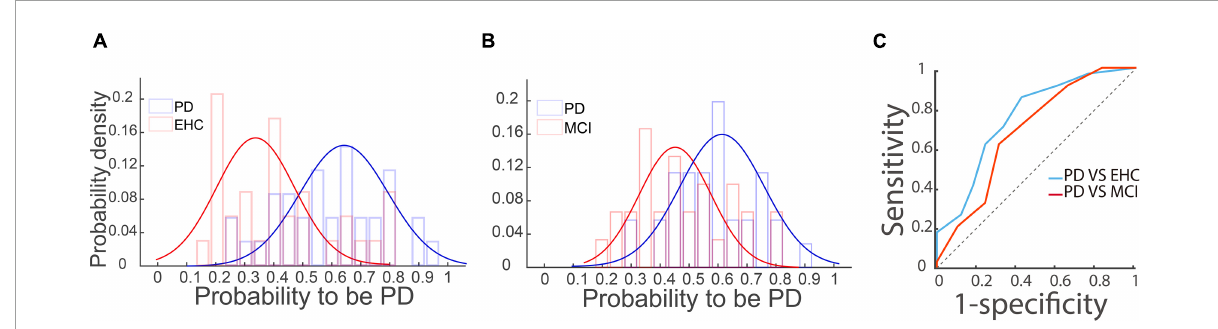
FIGURE5 Logistic regression and ROC analysis of the PD vs. EHC and PD vs. MCI groups. (A,B) The distributions of the probability of PD based on the logistic regression analysis are shown in panels (A,B) for the PD vs. EHC and PD vs. MCI groups, respectively. Blue and red curves represent the two unimodal distributions of the PD and EHC/MCI groups, respectively. (C) ROC curve of the probability of PD between the PD and EHC and MCI groups. The X -axis represents 1-specificity, and the Y -axis represents sensitivity. The AUCs of PD vs. EHC (blue curve) and PD vs. MCI (red curve) were 0.76 and 0.69, respectively. The dotted line is the diagonal line.